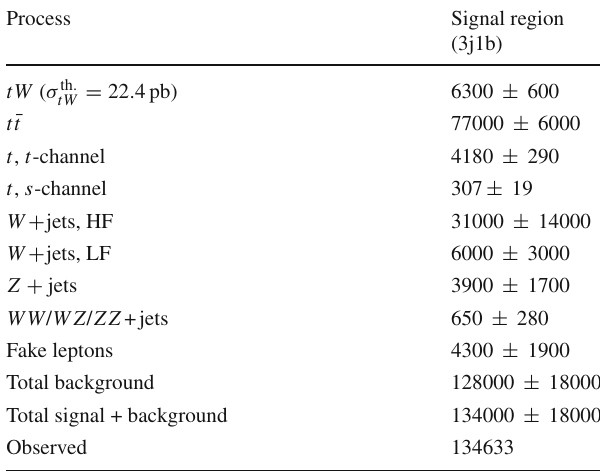
Table 1 Expected signal and background and observed number of events in the signal 3j1b region. The cross-section for tW production is taken to be the theory prediction. The uncertainties include statistical and systematic uncertainties